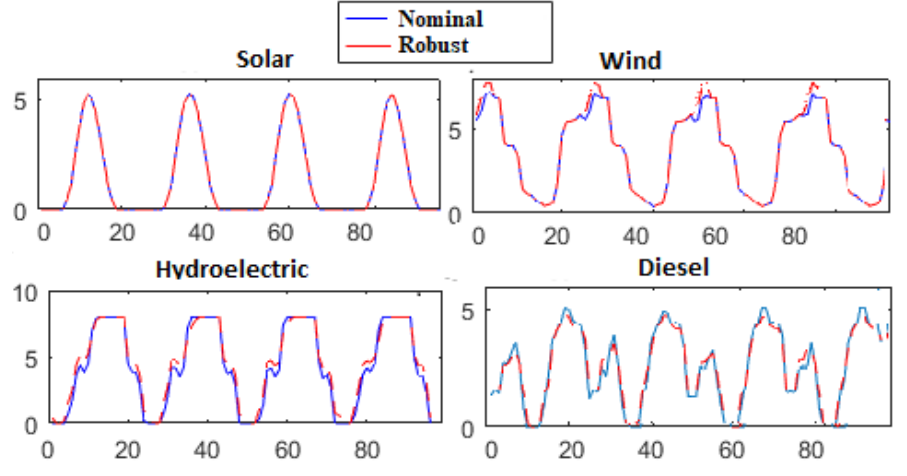
Figure 4. Sample winter plots of energy